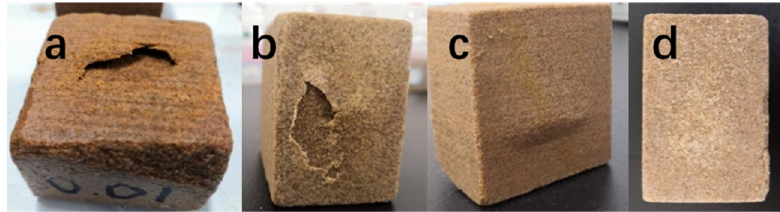
Figure 7. Three stone samples after 14 cycles: ( a , b ) sample 1 # , ( c ) sample 2 # , and ( d ) sample 3 # .